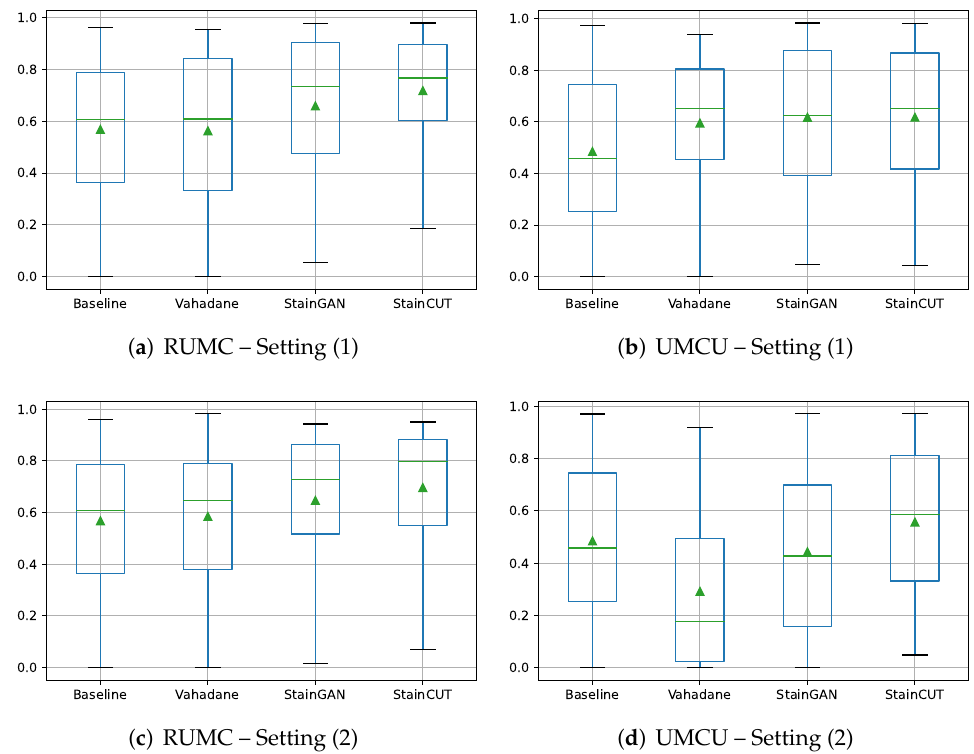
Table 6. Mean values of the dice coefficient score for the segmentation of both datasets, when the stain normalization is applied during evaluation (Setting 2). The dice coefficient is calculated by comparing the generated masks and the ground truth masks for each WSI. The corresponding statistical tests can be found in Tables 10 and 11 in Appendix C. using Setting (2) in Table 6. Each table shows the mean of the dice coefficient score from